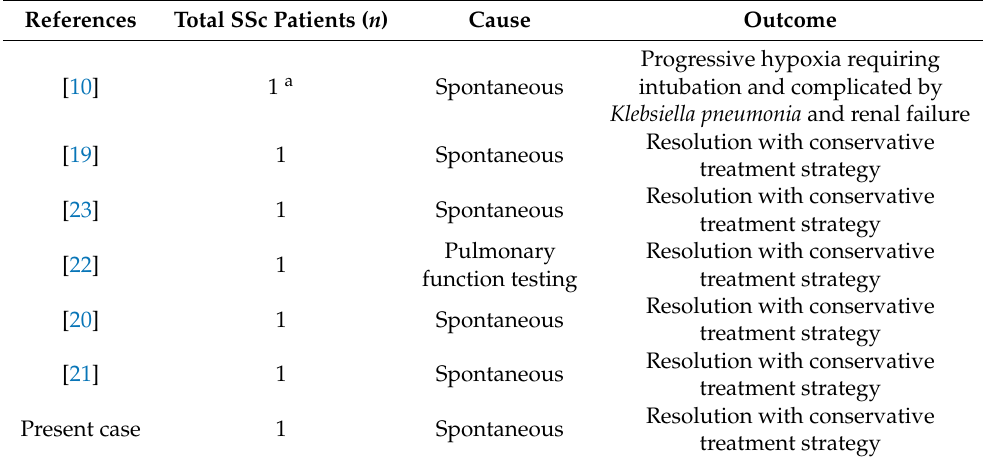
Table 1. Pneumo-mediastinum cases in systemic sclerosis (SSc) patients reported in the